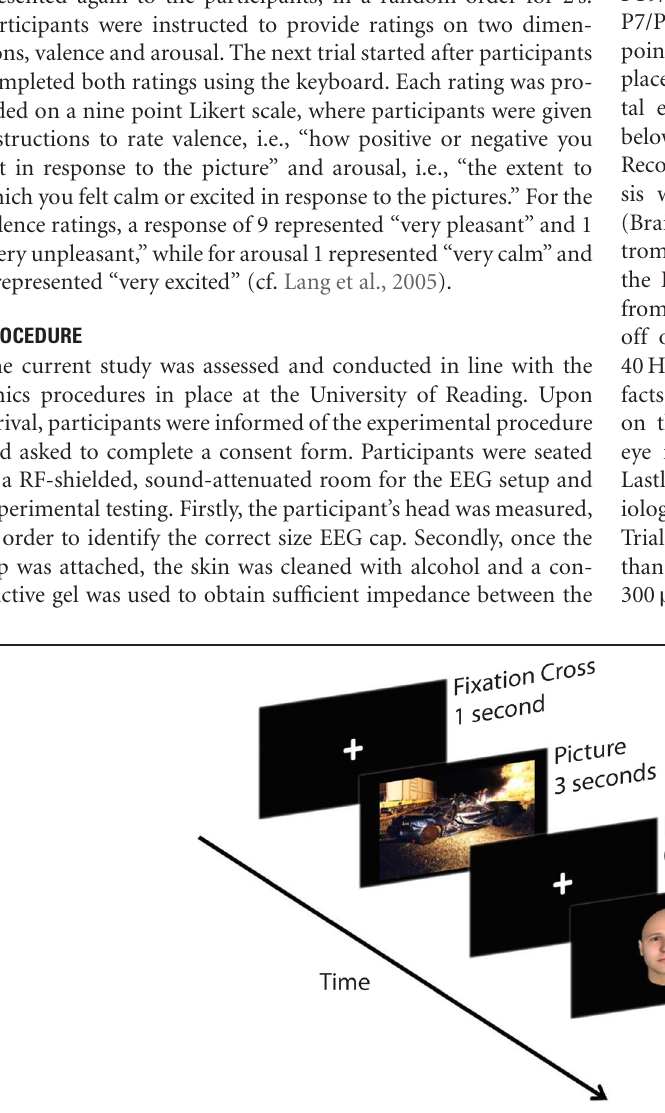
temporal interval. Lastly, a face-target was briefly presented. Participants were instructed to watch each picture and identify the gender of the following face-target as quickly and as accurately as